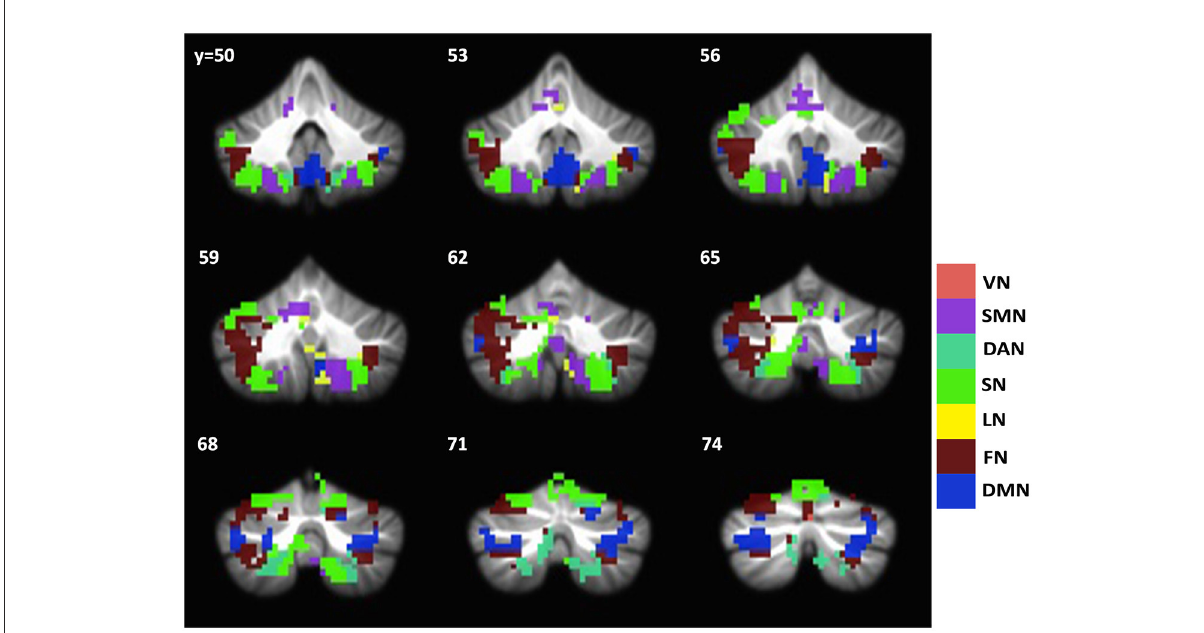
FIGURE3 Group difference map of caudate functional connectivity between svMCI and NC groups in the cerebellum. Brain regions showing significant group difference are distributed across all seven networks. The group difference map of cerebellum is overlayed with Buckner atlas for cerebellum. VN, Visual network; SMN, Somatomotor Network; DAN, Dorsal Attention Network; SN, Salience Network; LN, Limbic Network; FN, Frontal Network; DMN, Default Mode